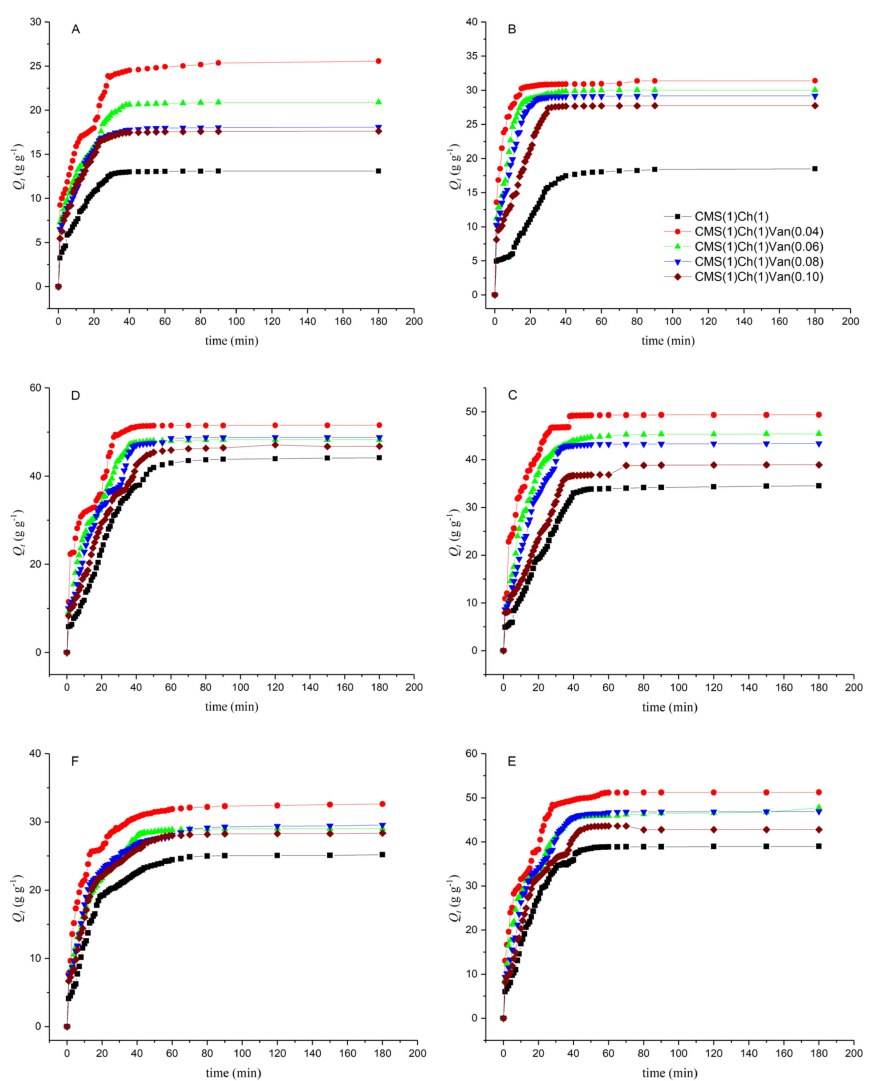
Figure 10. Influence of pH on the swelling capacity of synthesized hydrogels ( A ) solution with a pH of 1.48; ( B ) solution with a pH of 3.00; ( C ) solution with a pH of 4.30; ( D ) solution with a pH of 7.00; ( E ) solution with a pH of 9.70; ( F ) solution with a pH of